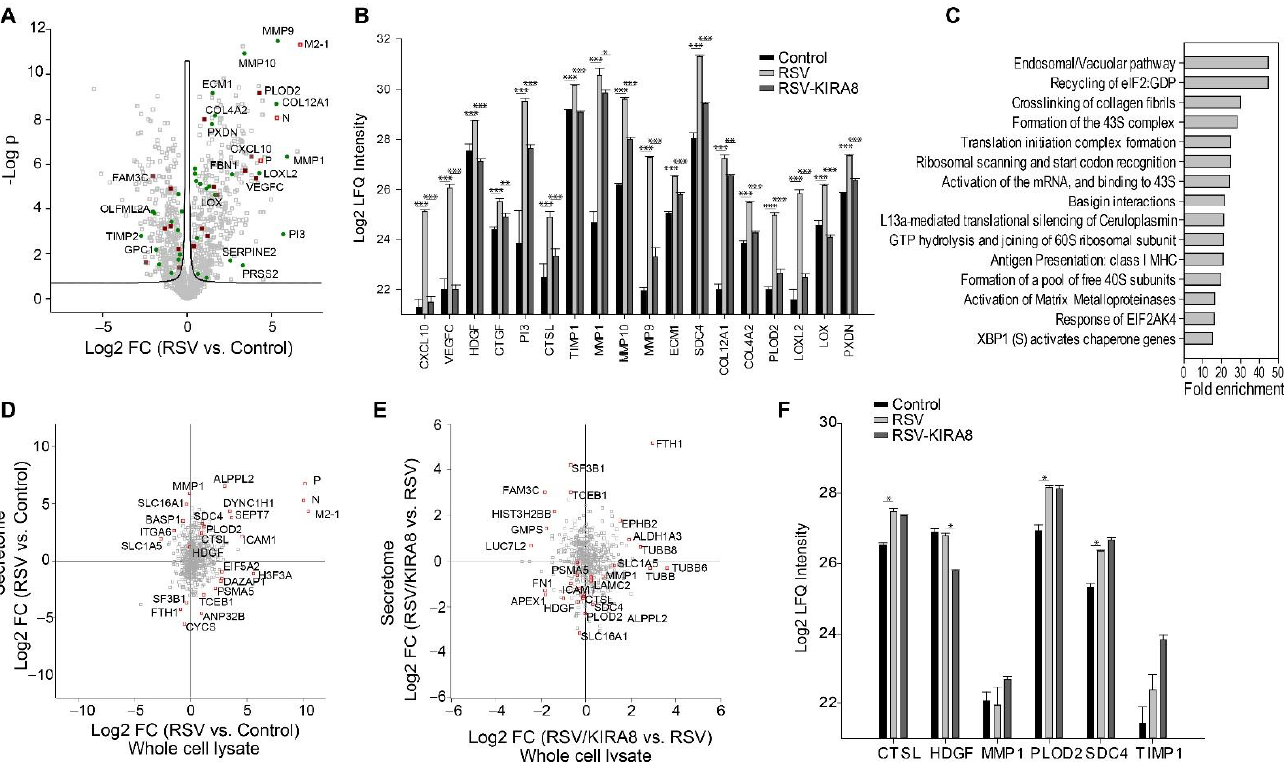
Figure 4. Proteomics analysis of secretome in hSAECs infected with RSV in the presence of KIRA8. hSAECs were infected with RSV at MOI 1.0 for 24 h in the presence or absence of KIRA8 (10 µM). The secretome was analyzed with label-free LC-MS/MS. ( A ) Volcano plot of secretome (RSV vs. Control). Dark red square, cytokines and growth factors; green circle, extracellular matrix proteins; and red open square, RSV proteins. ( B ) Examples of proteins whose secretion were significantly induced by RSV and blocked by KIRA8, including cytokines, growth factors, proteases, protease inhibitors, ECM, and ECM-modifying enzymes. ( C ) Pathways are strongly induced by RSV infec- tion and regulated by the IRE1 α– XBP1 arm of UPR (FDR < 0.05). ( D ) Correlation between proteome and secretome profiles (RSV vs. Control). ( E ) Correlation between proteome and secretome profiles (RSV-KIRA8 vs. RSV). ( F ) Protein expression of some proteins that were shown in Figure 4B. Stu-